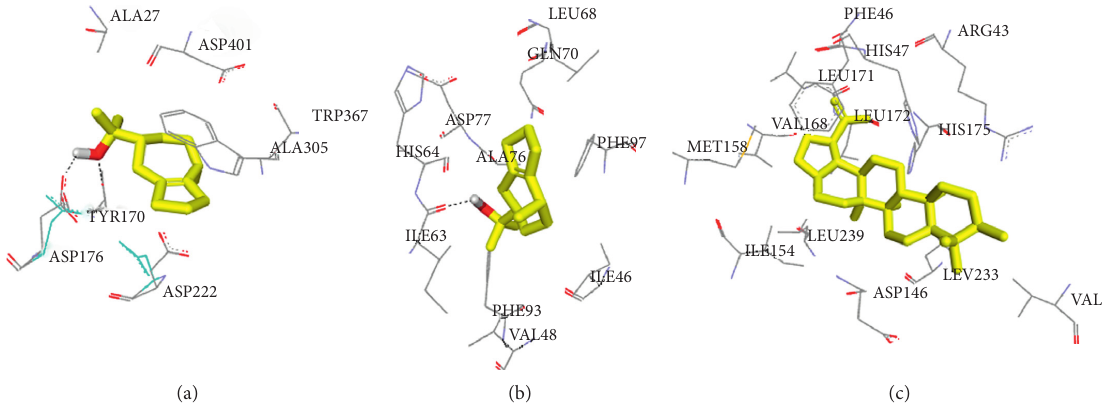
Figure 6: The binding conformation of (a) guaiol-cellobiohydrolase, (b) guaiol-laccase, and (c) lupene-peroxidase. The proteins are presented as the line form, and the ligands are presented as thick stick forms; yellow color represents carbon, red color represents oxygen, and white color represents